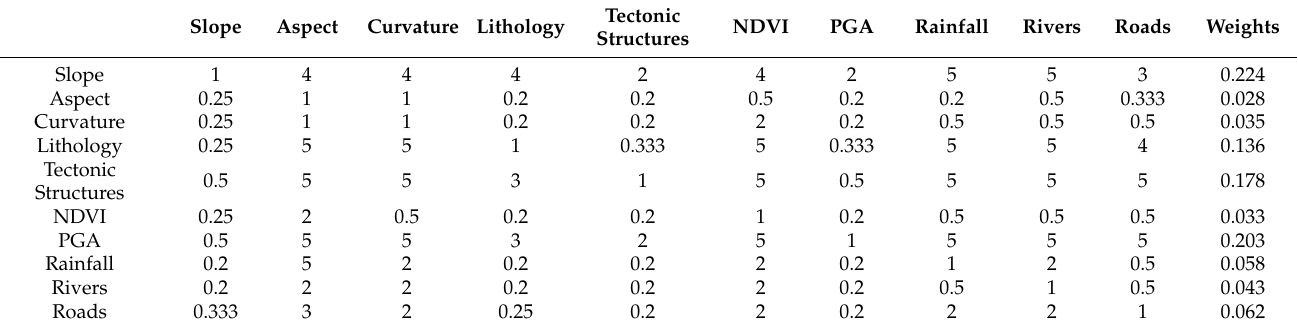
Table 5. Pairwise comparison matrix regarding the landslide causative factors as required for applying the AHP